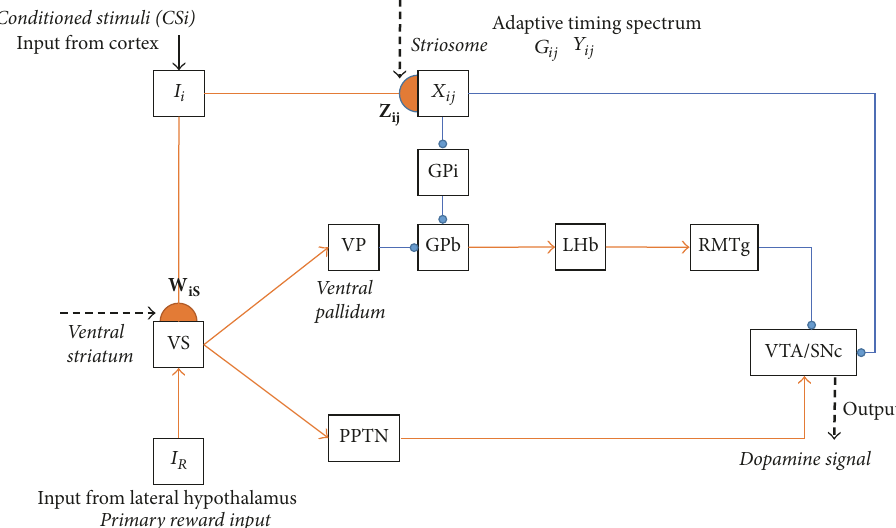
Figure 2: Model circuit. Orange arrowheads denote excitatory pathways, blue circles denote inhibitory pathways, and hemidisks denote synapses at which learning occurs. Black dashed lines denote dopaminergic signals. Evidence [21] shows that the ventral striatum (VS) excites PPTN and ventral pallidum (VP). Striosome neurons project to GPi neurons which in turn project to GPb. Dopaminergic (DA) neurons are excited by cortical inputs ( 𝐼 𝑖 ) encoding conditioned stimuli and lateral hypothalamus inputs (𝐼 𝑅 ) encoding unconditioned stimuli via the path VS-VP-GPb-LHb-RMTg-VTA/SNc and the path VS-PPTN-VTA/SNc path. DA neurons are inhibited by 𝐼 𝑖 via the path striosome-VTA/SNc. Note that the striosome contains an adaptive spectral timing mechanism and can learn to generate lagged, adaptively timed signals [16]. LHb neurons are excited by 𝐼 𝑖 via the path striosome-GPi-GPb-LHb. LHb neurons are inhibited by 𝐼 𝑖 and 𝐼 𝑅 via the path